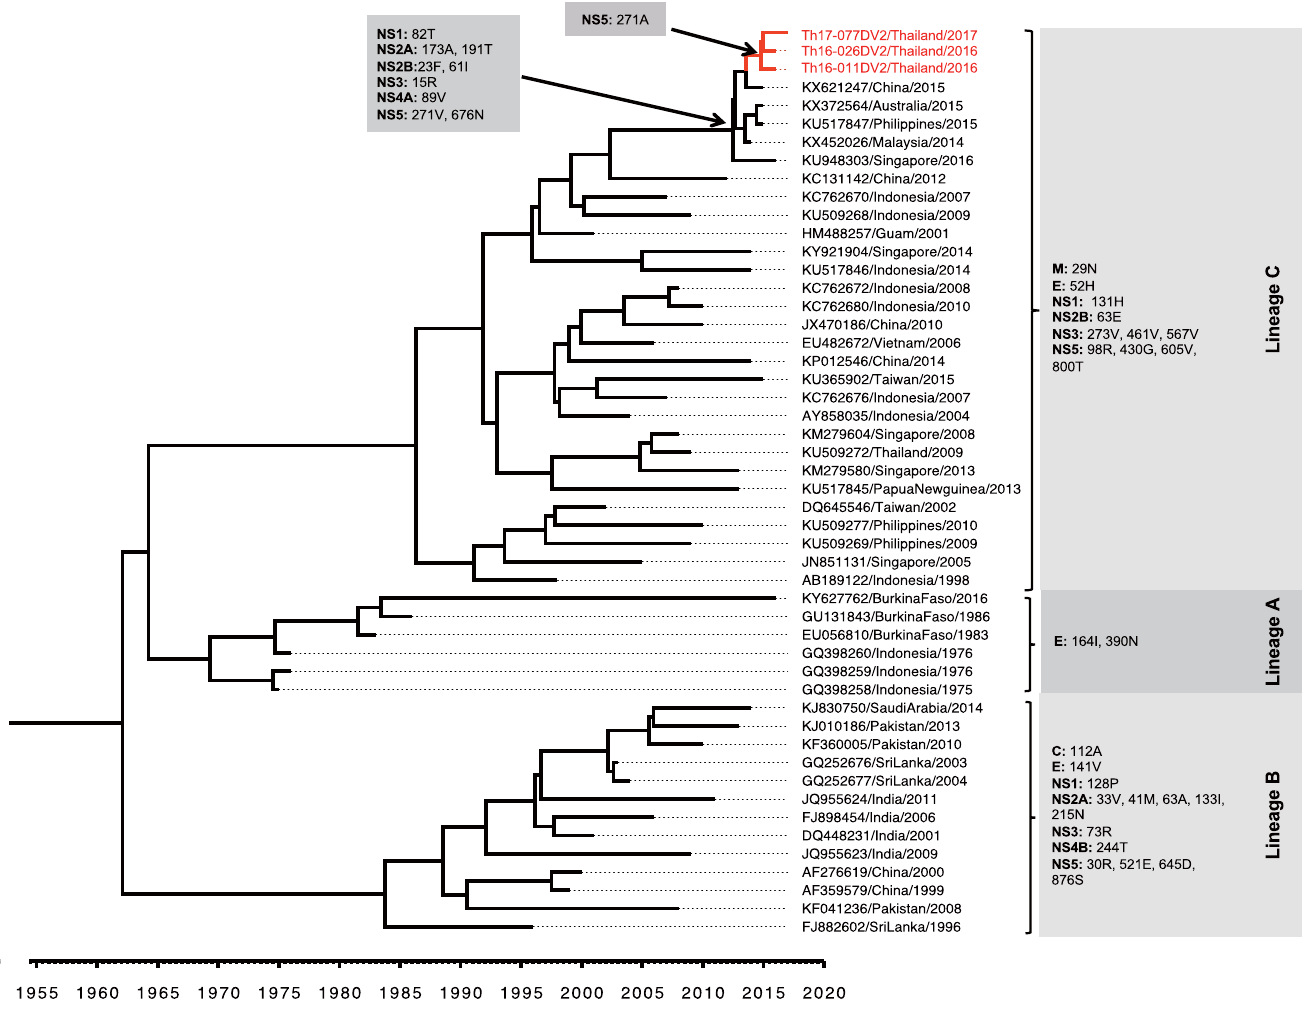
Fig 7. Amino acid variations among ORF proteins encoded by DENV-2 genotype Cosmopolitan. The amino acid substitutions in the open reading frames of the 3 lineages of DENV-2 genotype Cosmopolitan (in the right panel) are shown corresponding to the lineages. The occurrences of indicated amino acid variations are shown with arrows. Sequences obtained in the present study are labeled in